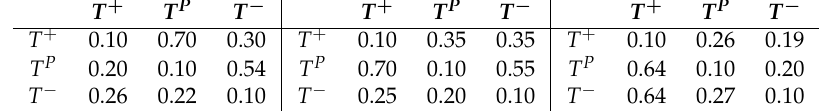
Figure 1. Schematic representation of a blood vessel and its ring-shaped zones 1–3. The area inside a blood vessel is called zone 0, and the rest of the torus is called zone 4. Table 1. Payoff matrices A 1 , A 2 , and A 3 for zone 1, (left), zone 2 (middle), and zone 3 (right),